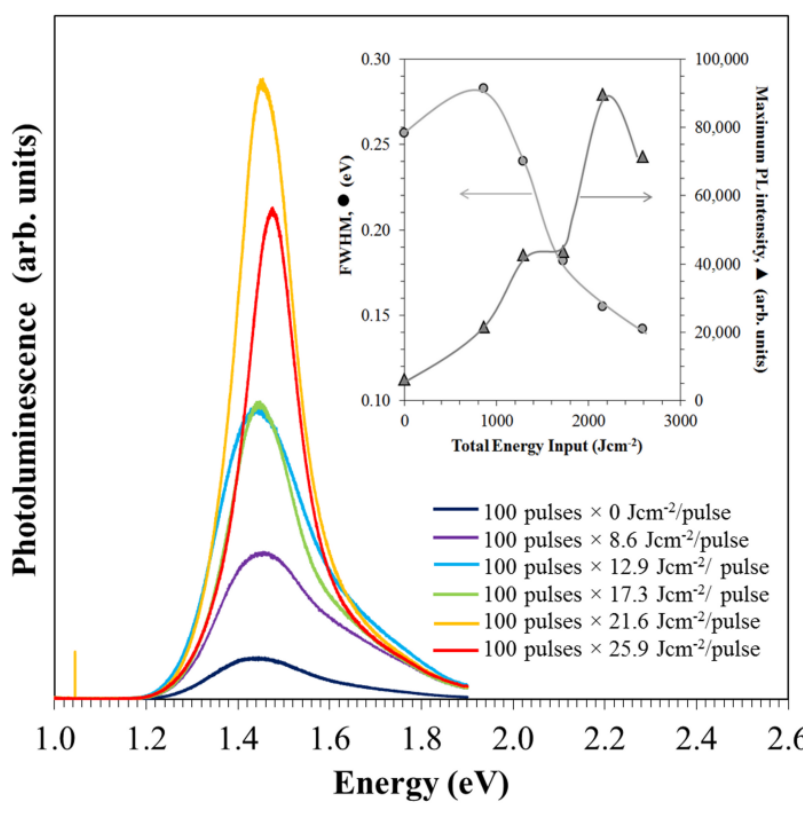
Figure 12. Room temperature photoluminescence (PL) studies of electrodeposited CdTe layers with intense pulsed light (IPL) treatments in air without CdCl